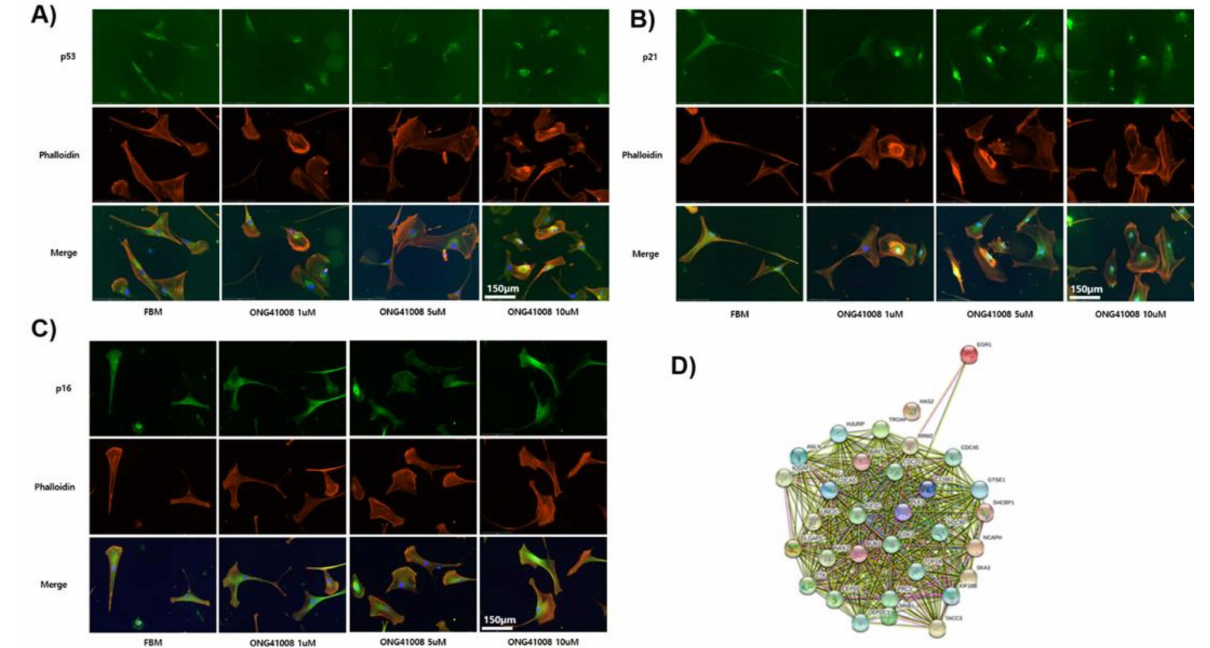
Figure 4. Translocation of TP53 to the nucleus, and induction and nuclear translocation of p21 and p16 in DHLFs upon ONG41008 treatment DHLFs were treated with 1 to 10 µ M ONG41008 or a control (RPMI medium). ICC was conducted with anti-human TP53, anti-p21, anti-p16, or phalloidin in conjunction with DAPI. ( A ) Translocation of p53 to the nucleus; ( B ) induction and translocation of p21 to the nucleus; ( C ) induction and translocation of p16 to the nucleus; ( D ) before or after induction of replicative senescence RNA-seqs were conducted and a nuclear interactome was generated by the String